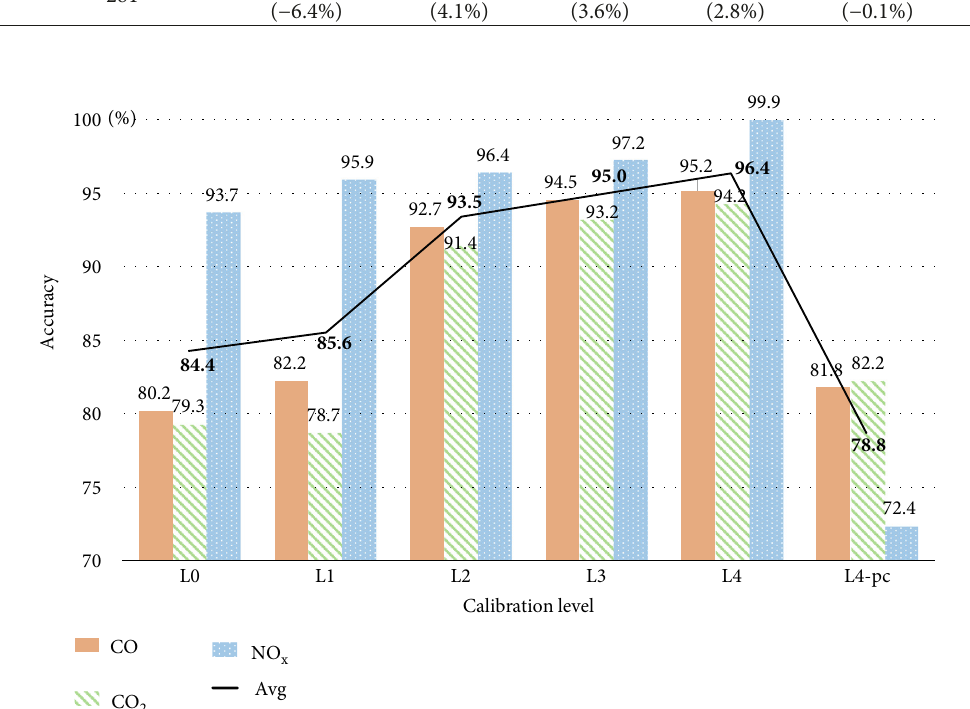
Figure 7: Accuracy of estimated emissions for each calibration